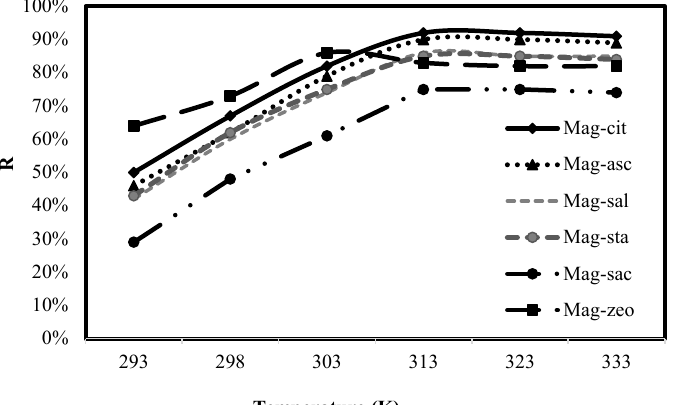
Fig. 9. Effect of temperature on the removal of Co(II) (adsorbents dose: 0.2 g, Co(II) concentration: 25 mg/L).